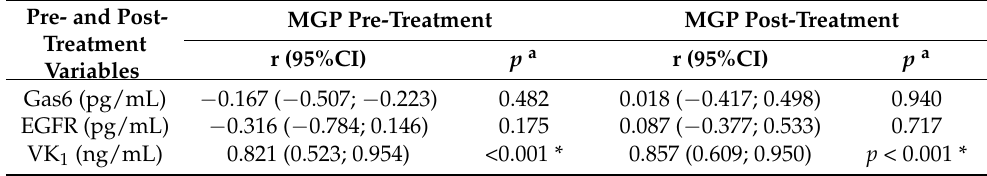
Table 3. MGP pre- and post-treatment correlations.